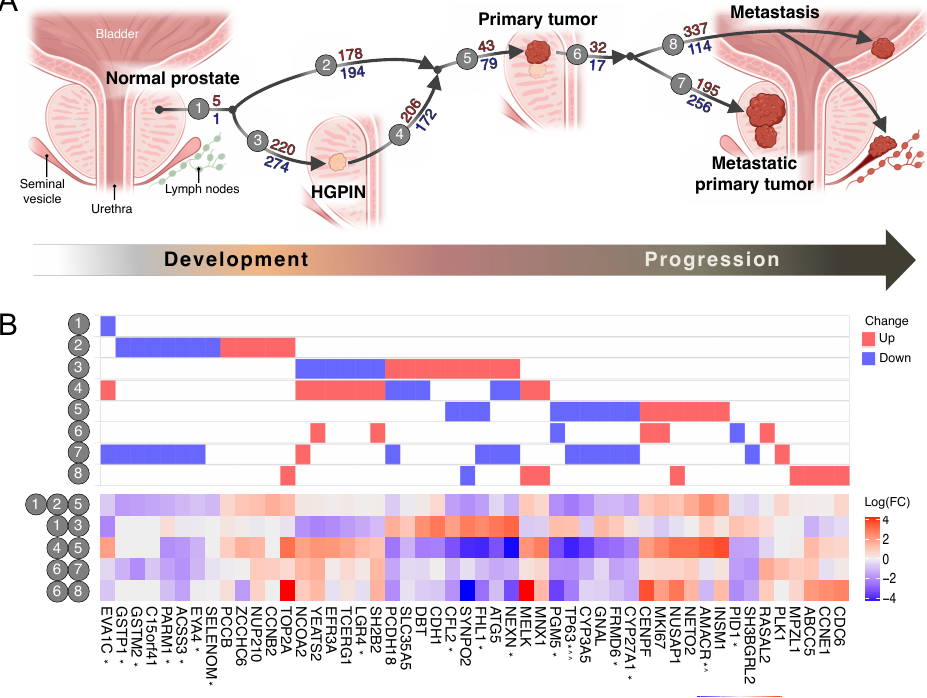
Figure 3. The transcriptomic landscape of prostate cancer development and progression. ( A ) Biological comparisons between tissue types were performed and the top 500 genes were used to assemble the molecular alteration map (MAM) of prostate transcriptional space (Methods). Circled numbers 1–8 indicate individual PC development or progression stages presented in the context of the prostate gland and surrounding organs. The number of up- and down-regulated genes between stages are indicated by red and blue text, respectively. ( B ) Diagram ( top ) and heatmap ( bottom ) illustrating the direction and fold-change (FC), respectively, of expression alterations for selected novel or biologically relevant genes across individual MAM stages ( top ) and biological comparisons ( bottom ). The FC values are presented in log 2 scale. * in silico prediction validated in a clinical cohort ( p -value < 0.05); ˆ positive control; ˆˆ negative control. Table 1. Genes associated with prostate cancer or